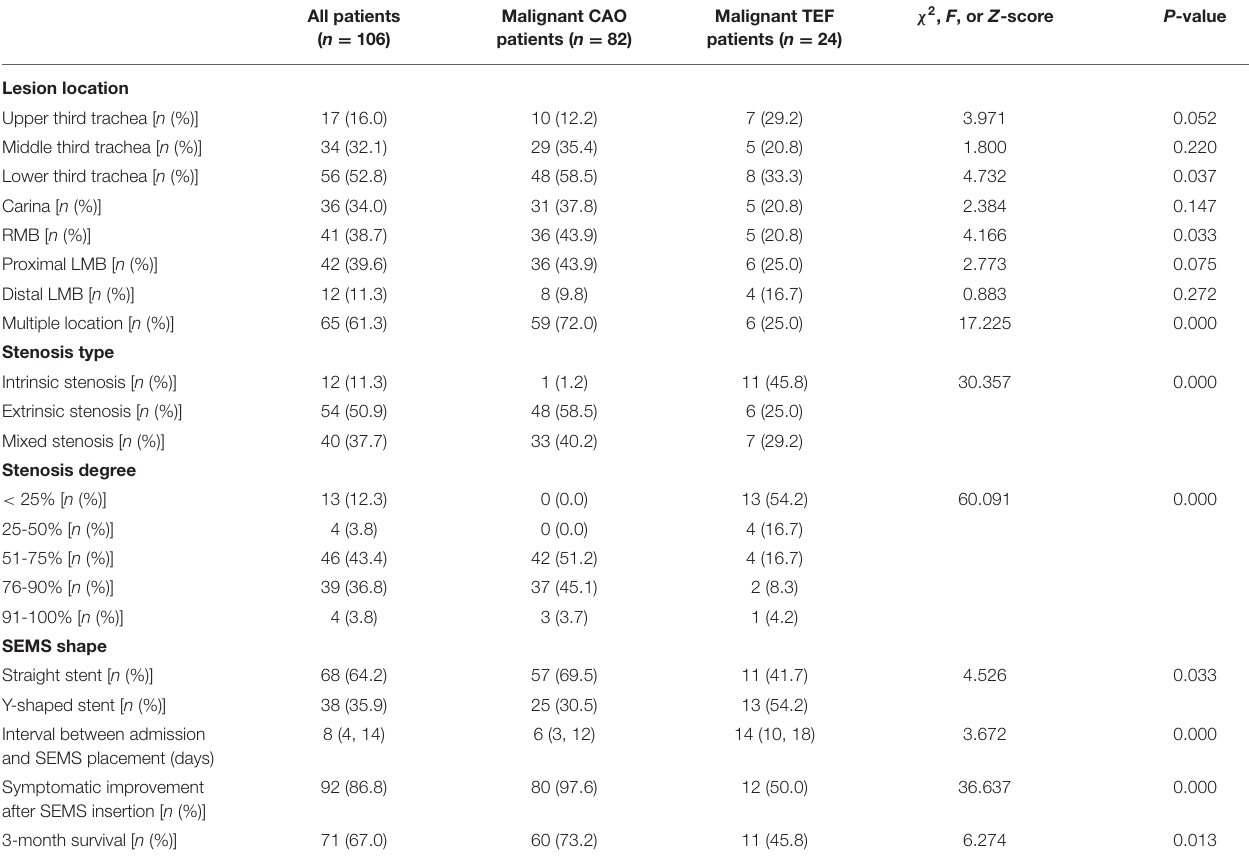
TABLE 3 | Airway disorders’ details, SEMS choices, and clinical outcomes between malignant CAO and malignant TEF patients.